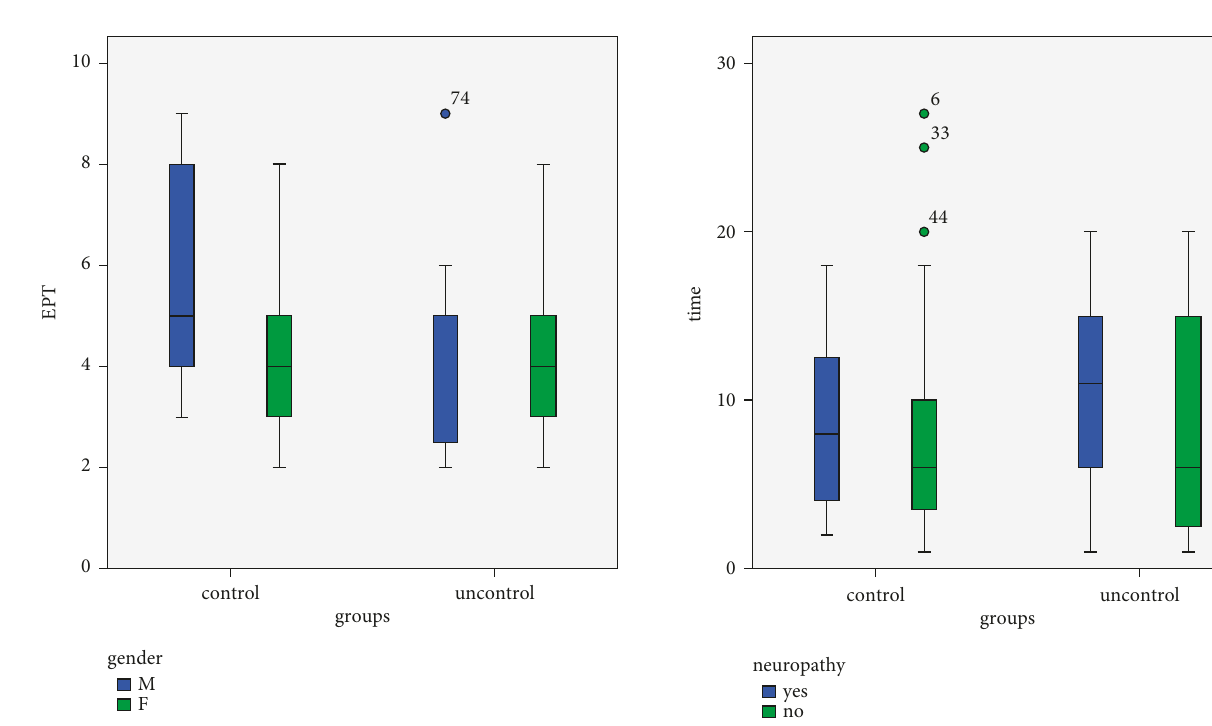
Figure 1: The relationship between EPT and diabetes based on gender.